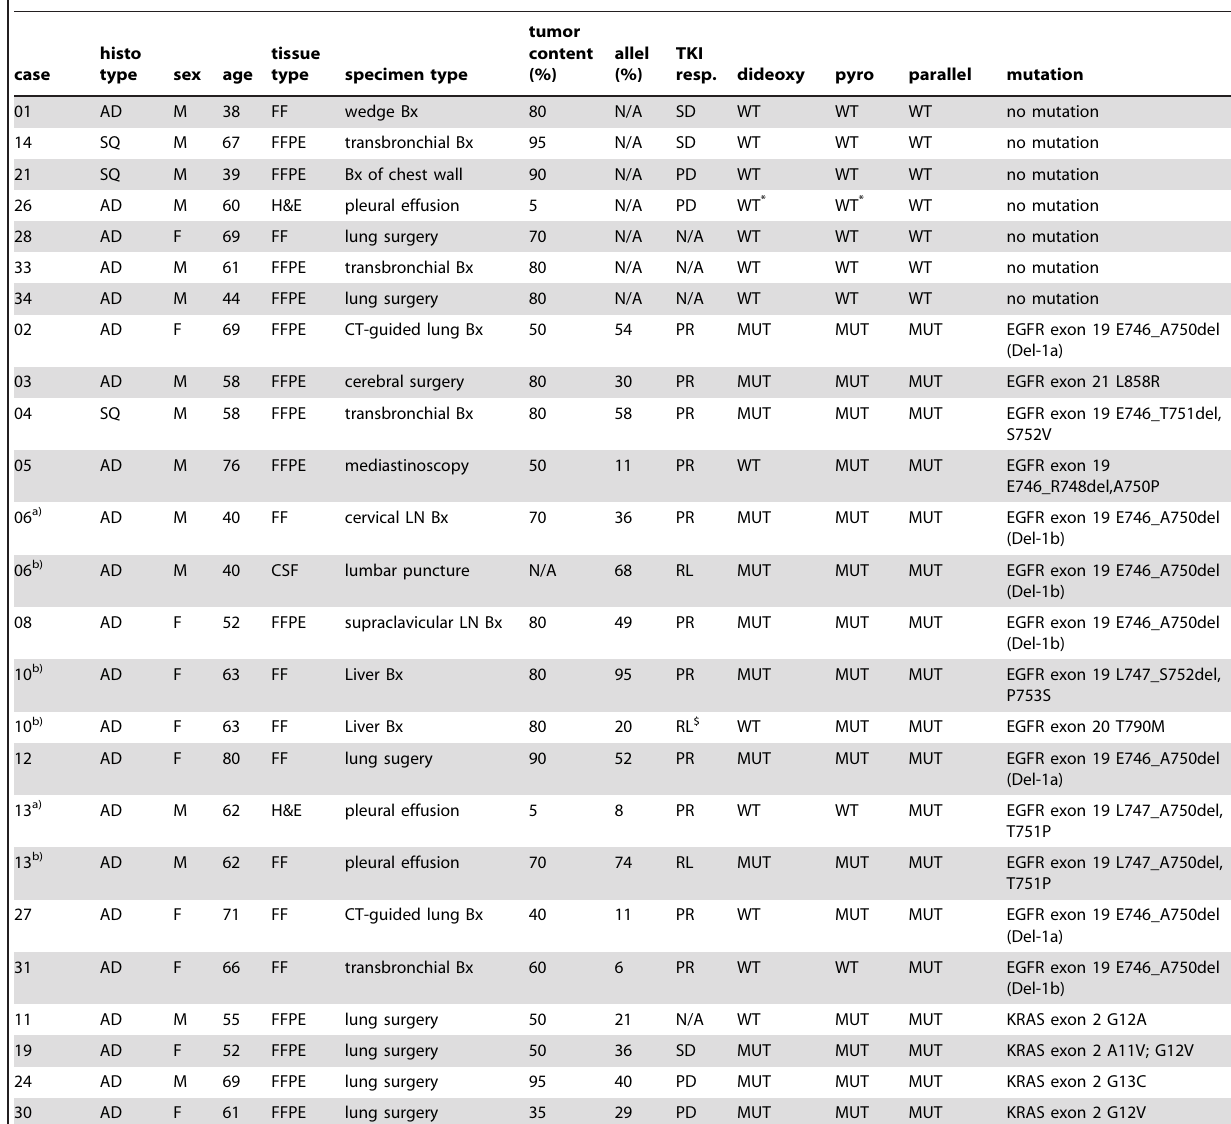
Table 1. Clinical characteristics and genomic alterations in NSCLC